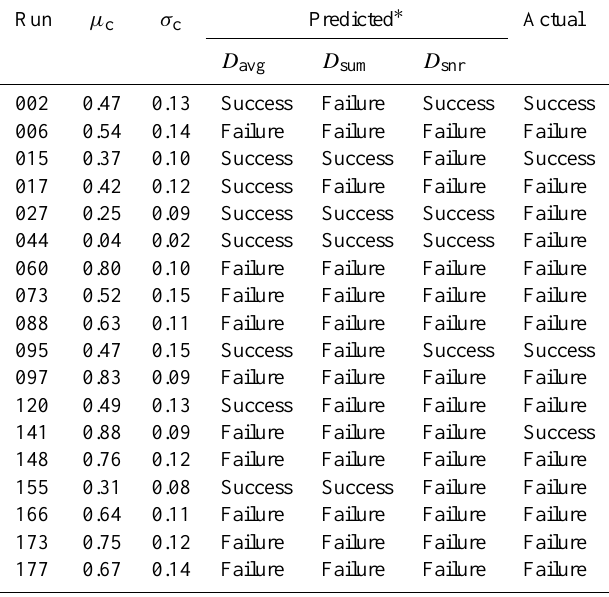
Table 3. Predictions and outcomes of simulation crashes in study